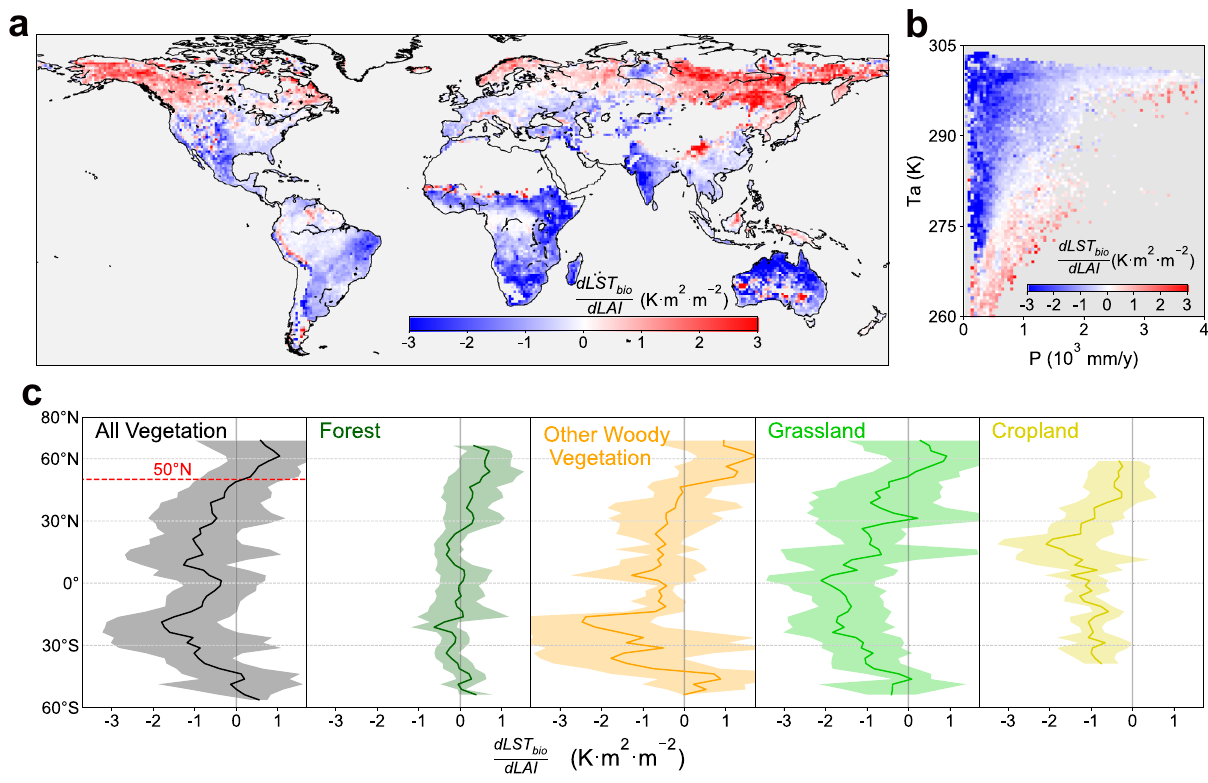
Fig. 1 | Annual biophysical sensitivity of land surface temperature to leaf area index ð dLS T bio dLAI Þ over the study period (2001 – 2018). a Spatial map of dLST bio dLAI . b Variationinsensitivitymeansacrosstheclimaticbins,inwhich dLST bio dLAI isbinnedas a function of annual precipitation (P, x -axis) and air temperature (Ta, y -axis).